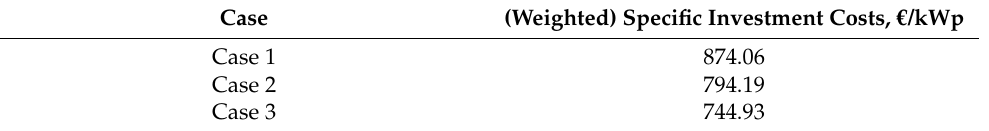
Table 4. Specific investment costs for Cases 1, 2, and 3.